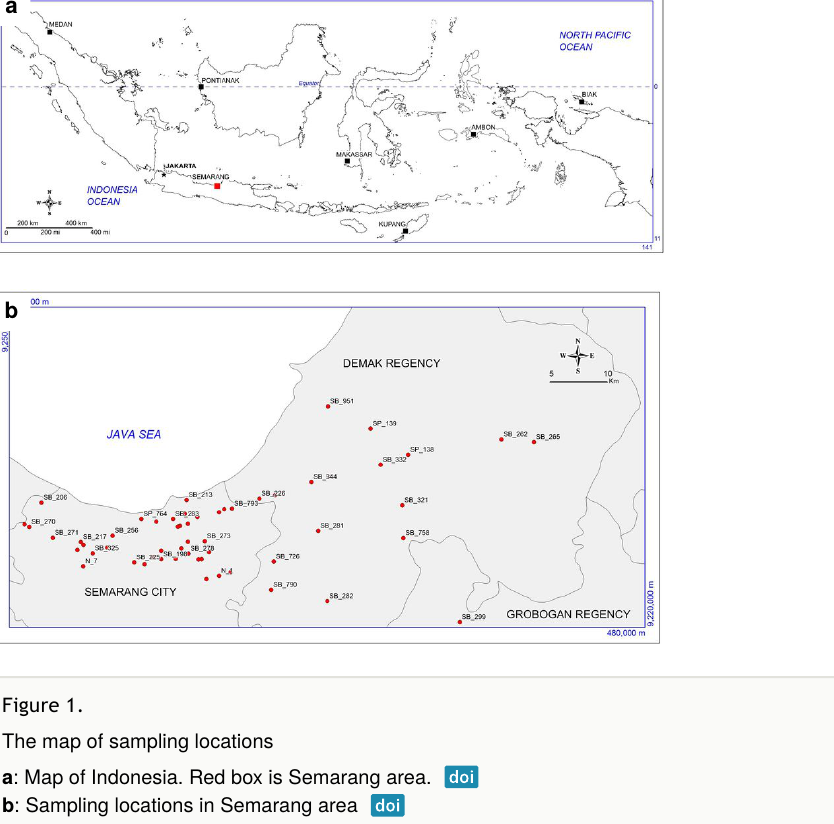
Figure 1. The map of sampling locations a : Map of Indonesia. Red box is Semarang